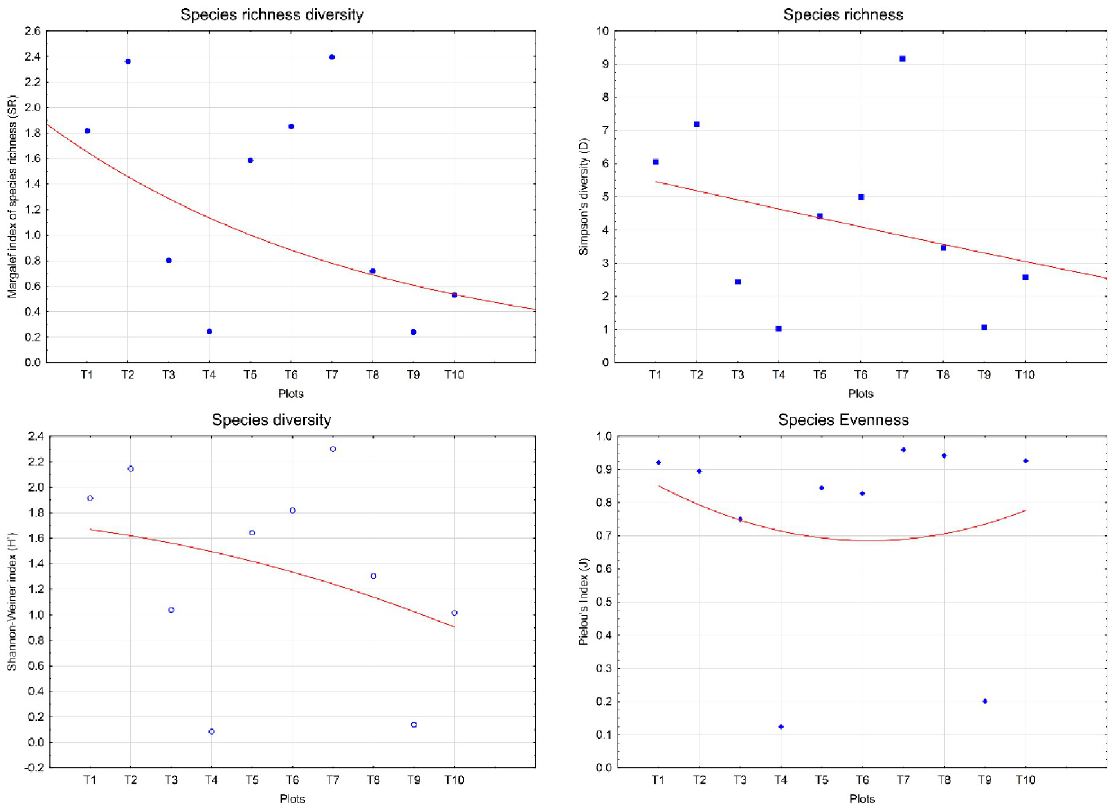
Fig 6. Patterns graph of species richness with each